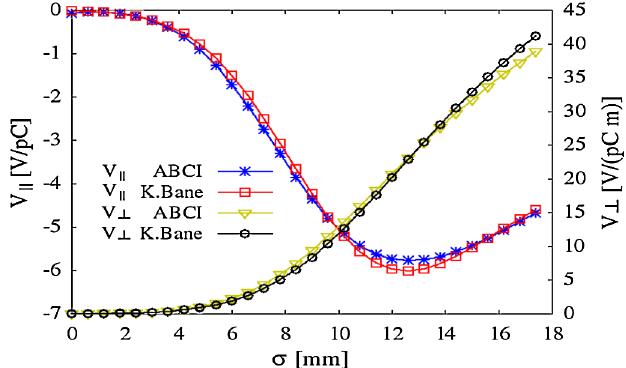
length.FIG. 2. Illustration of bunch frequency multiplication on CLIC DB DL. (a) Bunch phases with respect to the accelerating field phase on the linac. (b) Bunch phases with respect to the deflect- ing field phase. (c) Combination scheme.